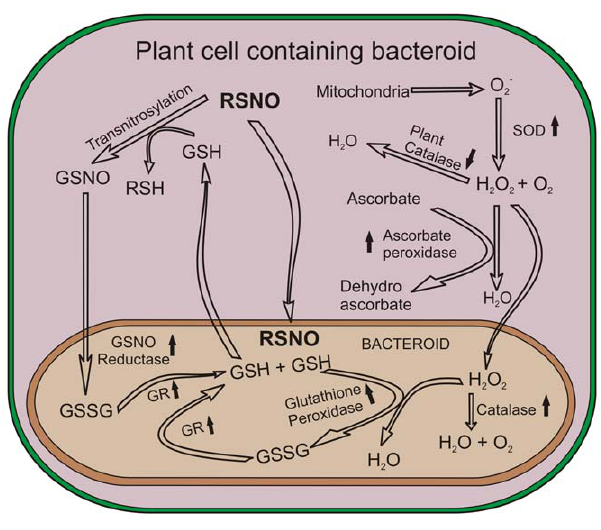
Figure 9. Representation of maintenance of Redox Cycle in nodules and bacteroid compartments. Scheme represents the nodule redox environment, and transport of redox molecules in plant cell compartment and bacteroid compartment. Based on the bio- chemical analysis of thiols, RSNO and redox active enzymes of plant cell and rhizobia, the exchange of molecules between the compartments has been shown. Upward arrow head indicates upregulation, down- ward arrowhead indicates downregulation. RSNO could be produced in the nodule compartment by several routes. Reduced glutathiones (GSH) take part in transnitrosylation reaction in nodule compartment. GSNO produced in nodule compartment may diffuse to the bacteroid cell where GSNO reductase could convert it to GSSG and NH 3 ; GSSG is recycled by GR and GPx. High basal level GR present in the bacteroid could recycle GSSG to GSH. GSH from the bacteroid may be transported to the nodule compartment to take part in the trans nitrosylation reaction. H 2 O 2 produced in nodule compartment could be detoxified by nodule catalase, and APx and the excess H 2 O 2 might be diffused to the bacteroid compartment where Bradyrhizobium could detoxify it with high level of catalase and GPx.